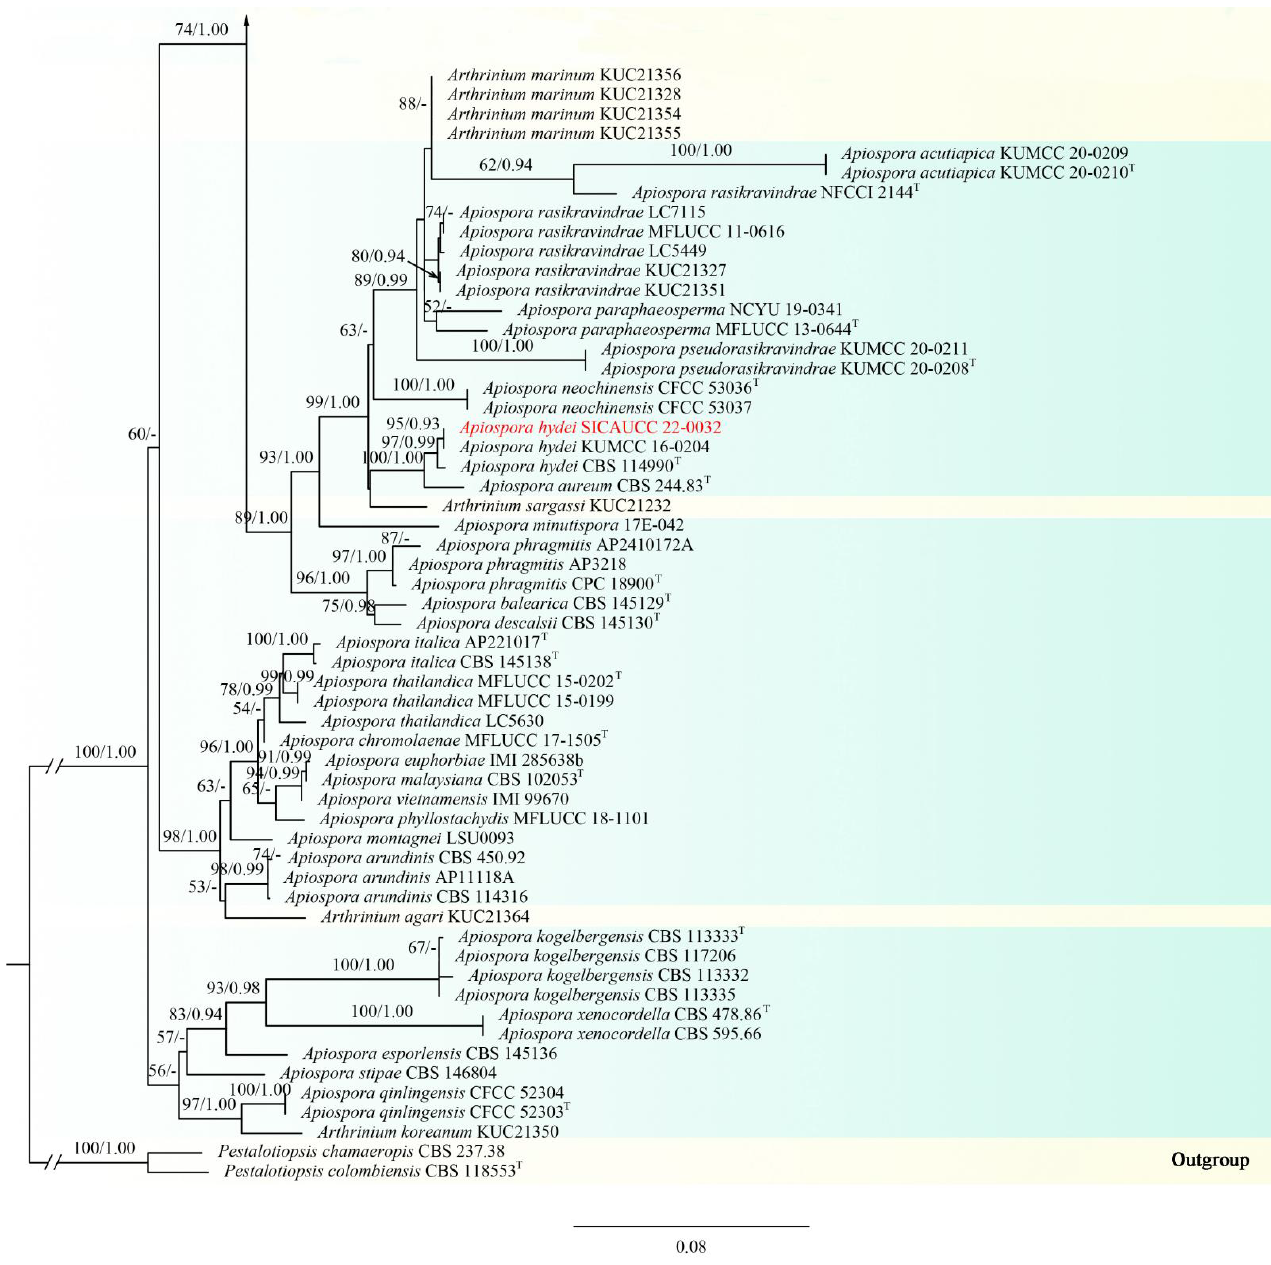
Figure 1. Phylogram generated from RAxML analysis based on combined ITS, LSU, tub2, and tef1- α sequence data of Apiosporaceae. Bootstrap support values for maximum likelihood (ML, left) higher than 50% and Bayesian posterior probabilities (BYPP, right) equal to or greater than 0.90 are indicated at the nodes, respectively. The sequences from ex-type strains are marked by a superscript symbol T. The newly generated sequences are written in red. Arthrinium species with yellow background were temporarily not combined to Apiospora .